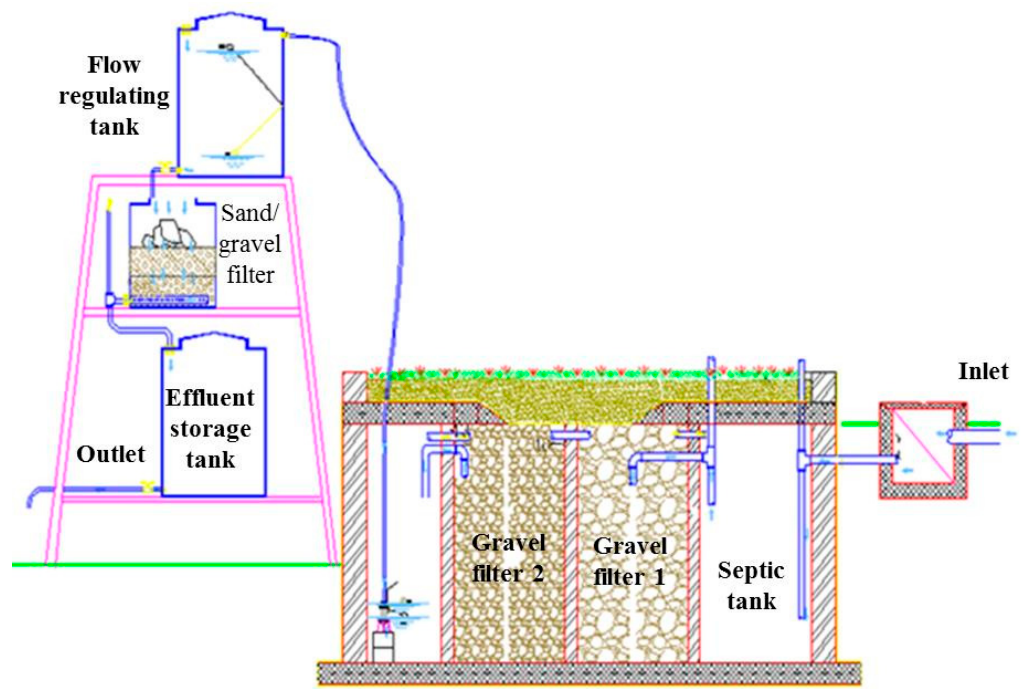
Figure 3. Onsite grey water treatment plant [23].